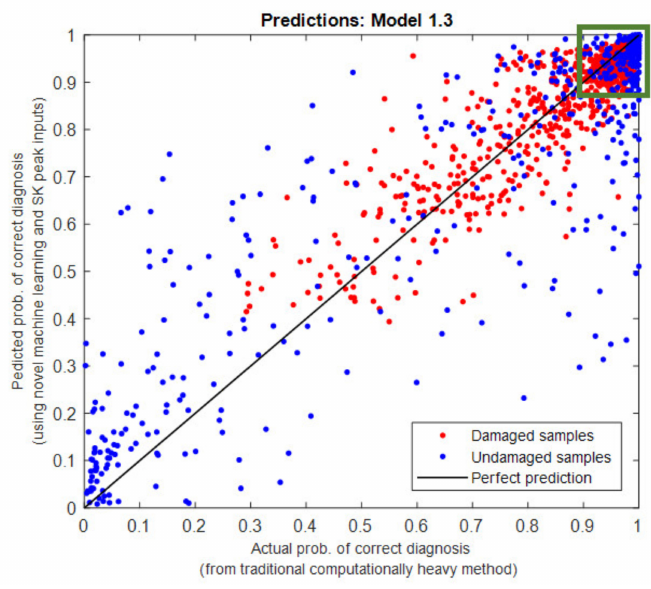
Figure 13. Machine learning output